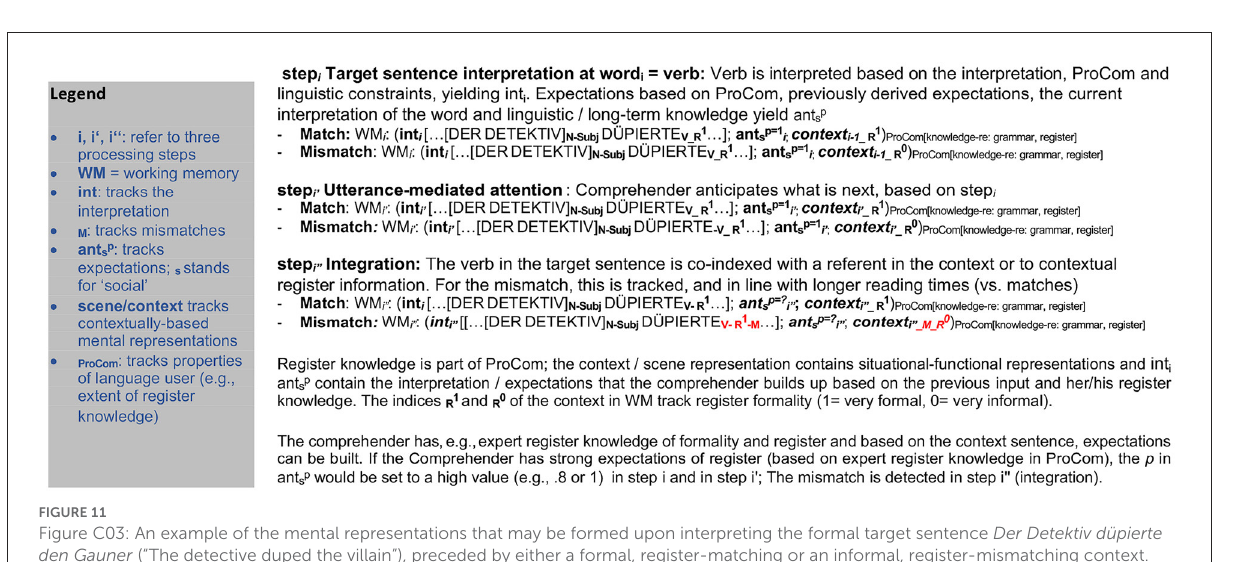
effects not only in British and American English, but